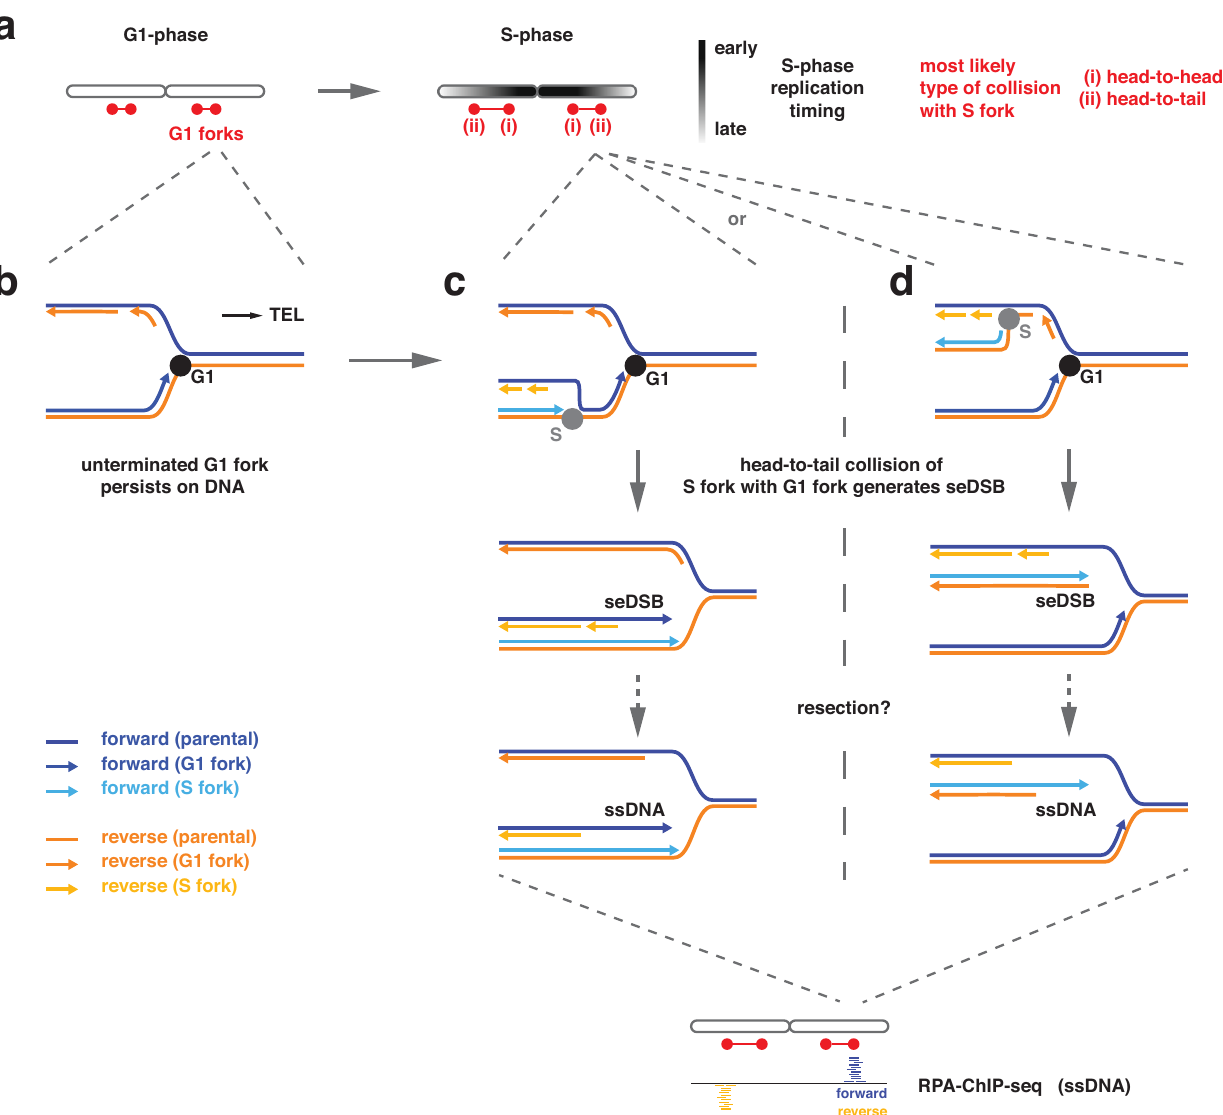
telomere will encounter the same events just with opposite strand directionality. Unterminated forks persist after unscheduled replication in G1 due to incomplete duplication/missingtermination. c , d Head-to-tailcollisionofanS-phasereplication fork with an unterminated G1 replication fork. A single-ended double-strand break (seDSB)occurs independent ofwhether the S-phase replication fork travelson the parental reverse strand ( c ) or the reverse strand synthesized by the G1 replication fork ( d ). Single-stranded DNA (ssDNA) could either be directly exposed during seDSB generation (due to incomplete lagging strand replication) or afterwards